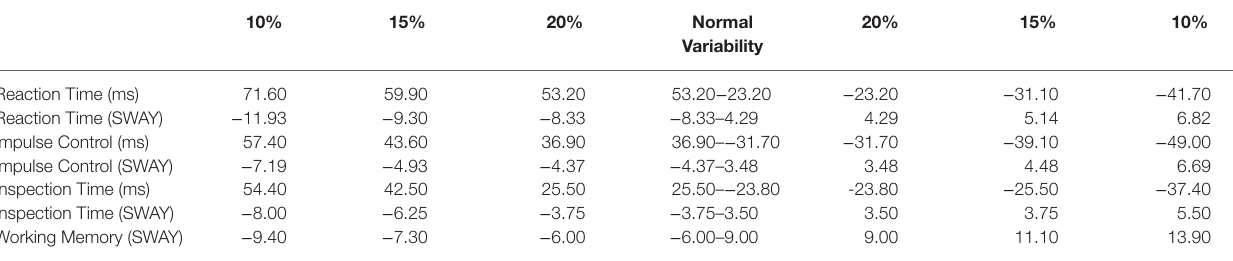
TABLE 4 | Interpreting change based on the natural distribution of Week 2–Week 1 difference